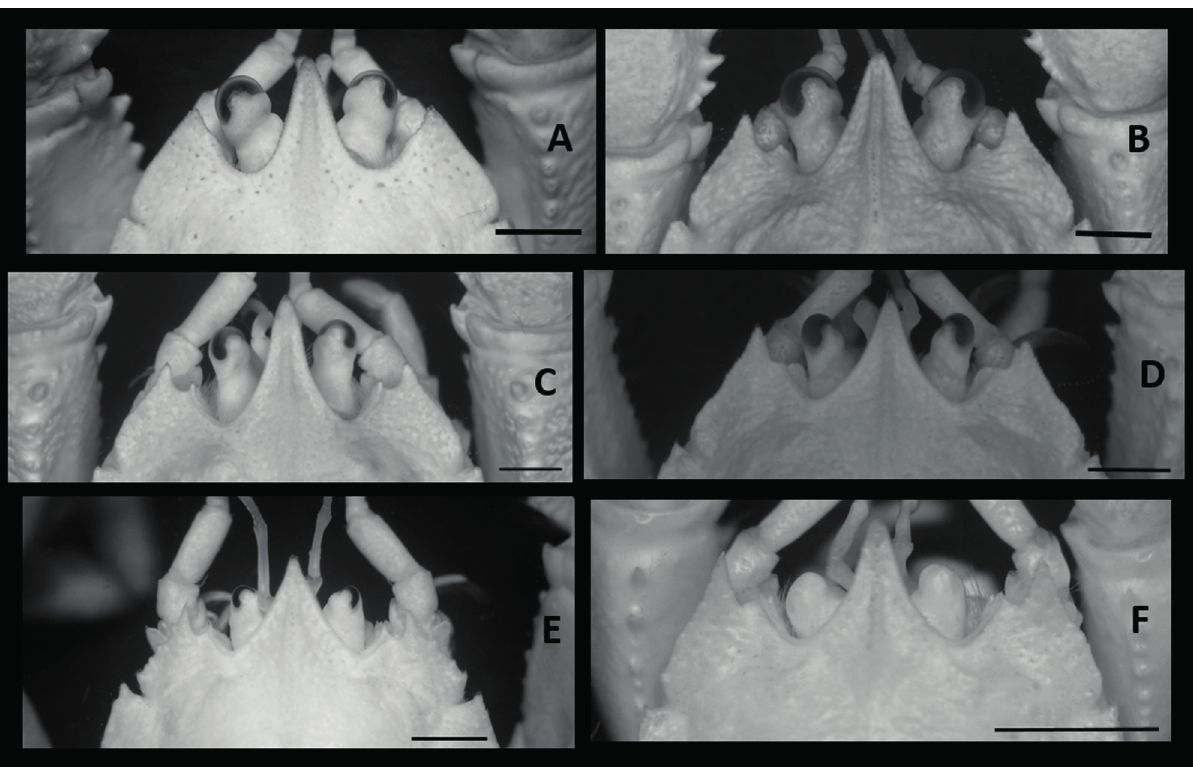
Figure 12. Distal portion of anterior region of carapace showing relative difference in size of pigmented area of cornea among aeglids: Grade 0 (fully developed) in the epigean species Aegla perobae (A) and in the stygophilic species A. strinatii (B). Grade 1 (slightly reduced) in the stygobitic species A. charon n. sp. (C), and A. leptochela (D). Grade 2 (greatly reduced) in the stygobitic species A. cavernicola (E). Grade 3 (absent) in the stygobitic species A. microphthalma (F). All species are endemic to Alto Ribeira karst region, except A. perobae , which is endemic to the Tietê Hydrographic Basin. Scale bars = 2.0